Question: Write a single sentence explaining what this figure depicts.
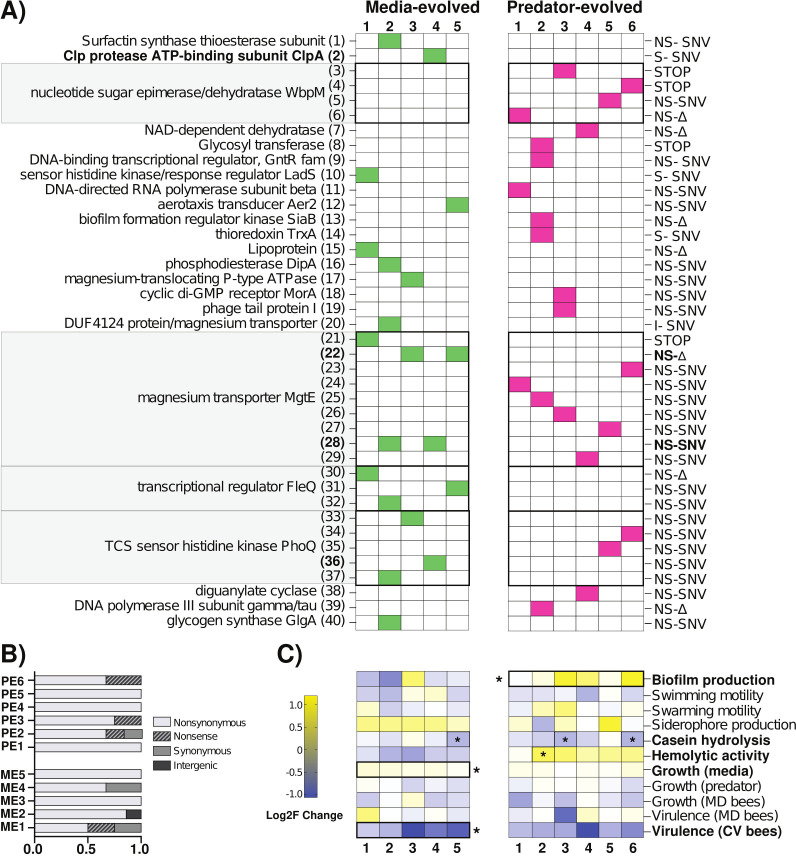
Answer: Genotypic and phenotypic changes in evolved isolates. ( A ) Mutations identified in evolved isolates, highlighting site-specific parallel mutations (bold font) and gene-specific parallel mutations (outlined boxes). NS, nonsynonymous; S, synonymous; I, intergenic; STOP, nonsense; SNV, single-nucleotide variant; ∆, deletion; +, insertion. For a list of all mutations identified in the evolved isolates, see Data set S3 . ( B ) Proportions of mutation types (NS, S, I, STOP) present in each isolate. ( C ) Log₂ fold change calculated from the mean of all replicates and trials for each phenotype measured in evolved isolates relative to the ancestral strain. Yellow indicates an increase, blue indicates a decrease, and white indicates no change. Asterisks within boxes indicate significant differences when individual isolates were compared to the ancestor, whereas asterisks in the margin indicate significant differences when the mean of all ME lines or all PE lines was compared to the ancestral mean. Bold text denotes phenotypes showing significant changes relative to the ancestor. Statistical significance was determined using a Kruskal–Wallis test with Dunn’s multiple-comparisons test ( P < 0.05). Multiple-comparison corrections were applied independently within each phenotypic assay rather than across the full set of measured traits. Full data for all replicates, including non-log₂ fold-change values, are shown in Fig. S4 and S5 .